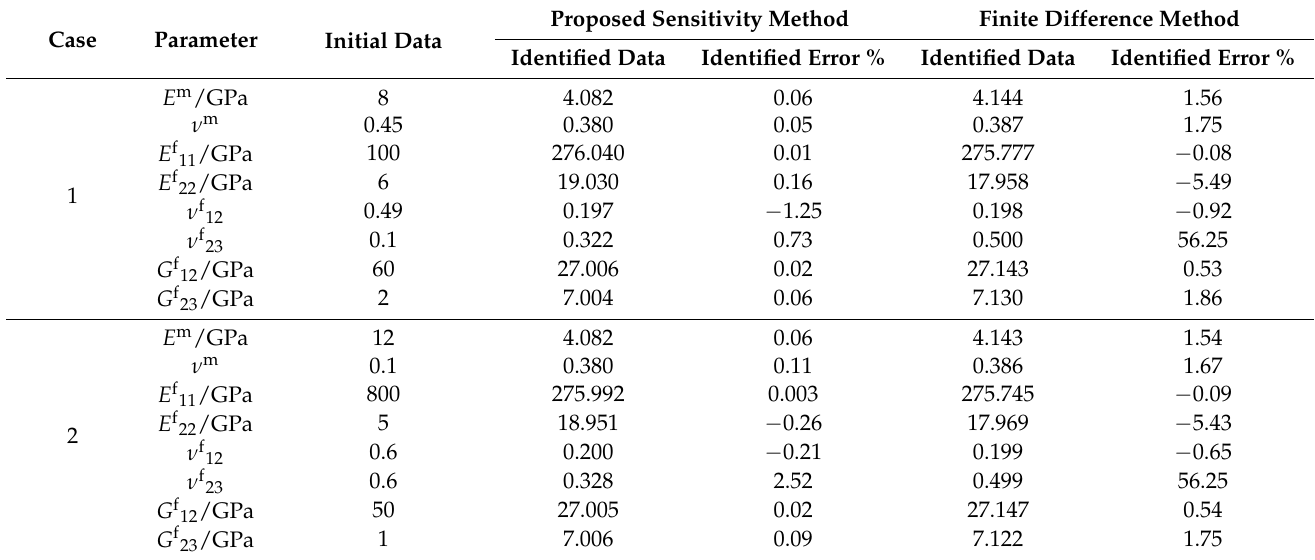
Table 4. Identification results for two sensitivity measuring method (seven points).